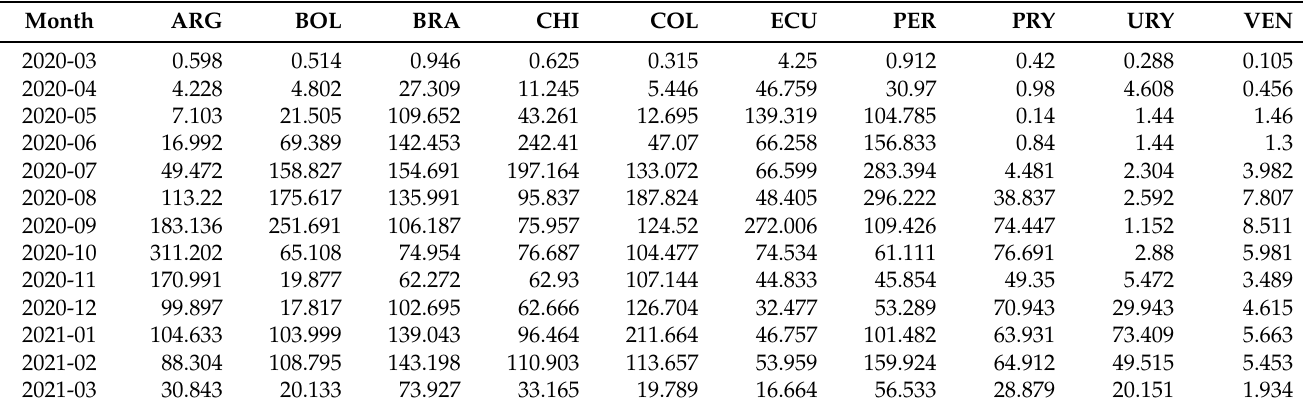
Table 4. Data matrix of the number of COVID-19 deaths per million inhabitants for the indicated month and country.